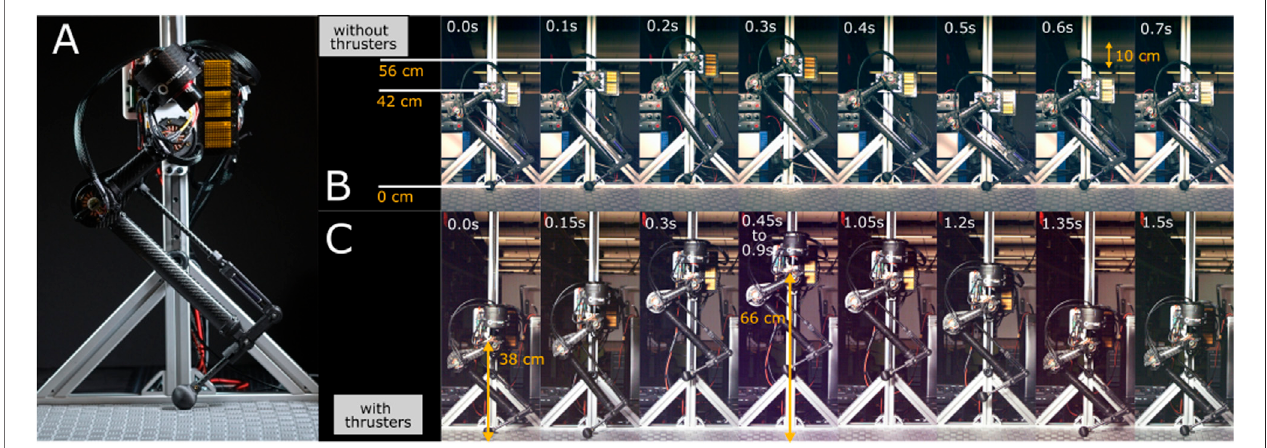
FIGURE2|(A) IllustratesthecurrentstatusoftheongoingHarpyhardwaredevelopmentsatNortheasternUniversity. (B,C) Showsuccessfulmono-pedaljumping tests with and without thrusters. A gantry supports the half- fi nished prototype in these tests.